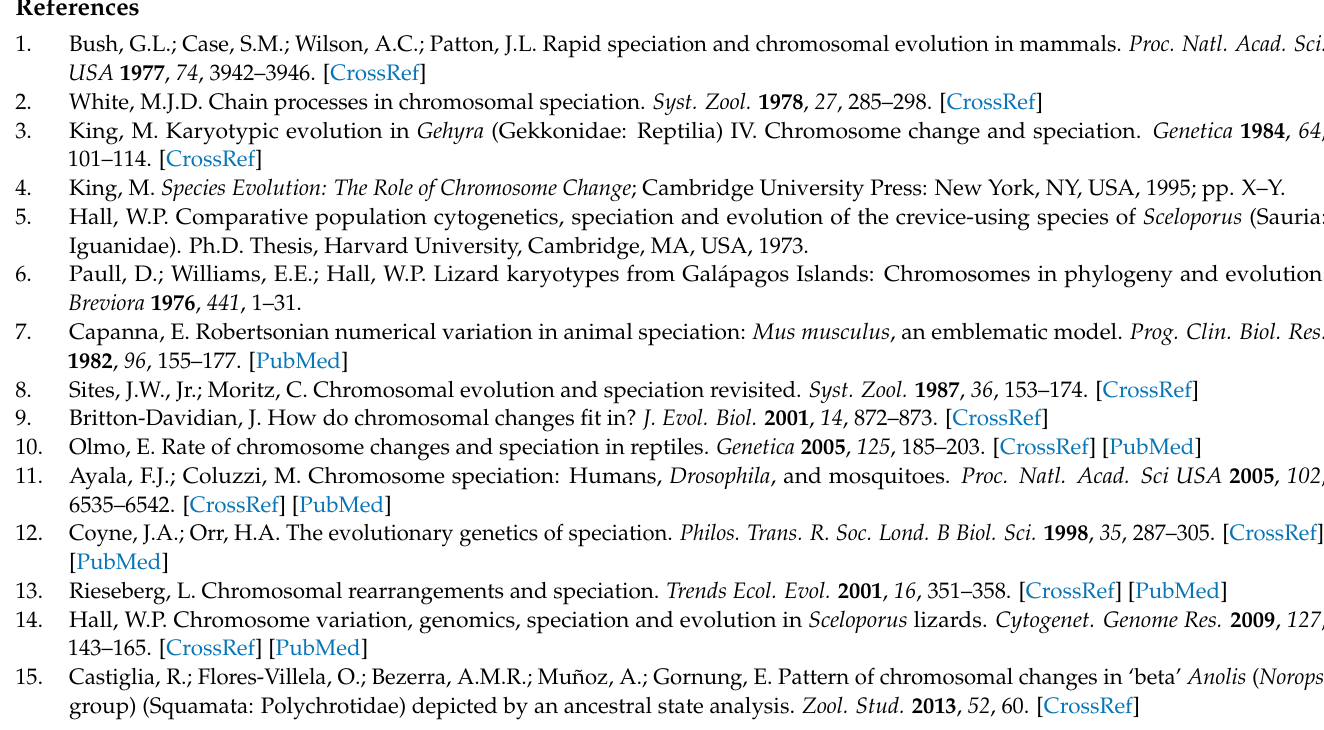
Figure S1. Representative meiotic karyotype for the first seven chromosome pairs for lizards from the newly described chromosomal races of Liolaemus monticola . Figure S2. Model of evolution for the chromosome pair 2 in Liolaemus monticola in the Multiple Fission